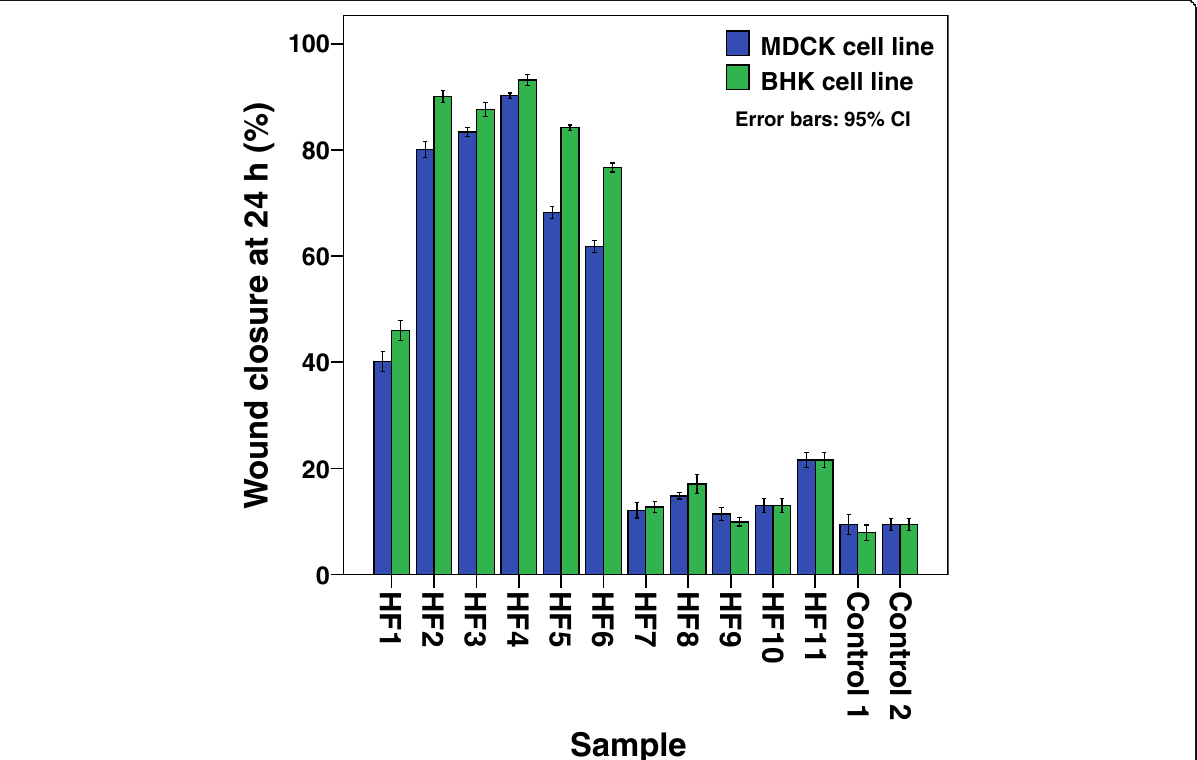
Fig. 4 Percentage wound closure in the presence of column fractions of F. racemosa hexanes extract on BHK and MDCK cell lines. (Bars represent the mean and confidence intervals of 95% of nine measurements in the three experiments)